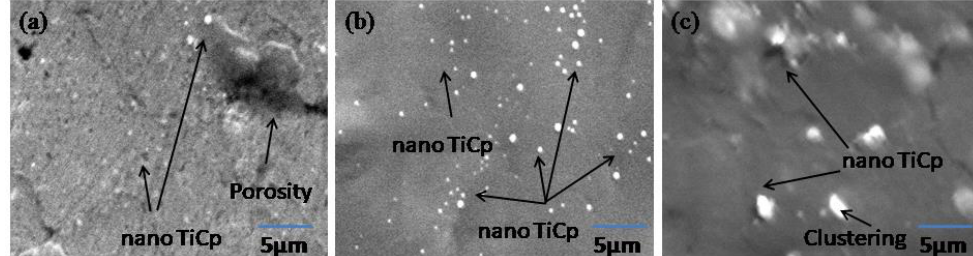
Figure 8. SEM Image of ( a ) Al 2wt %, ( b ) Al 4 wt % and ( c ) Al 6 wt % nanoTiC p composite after annealing.